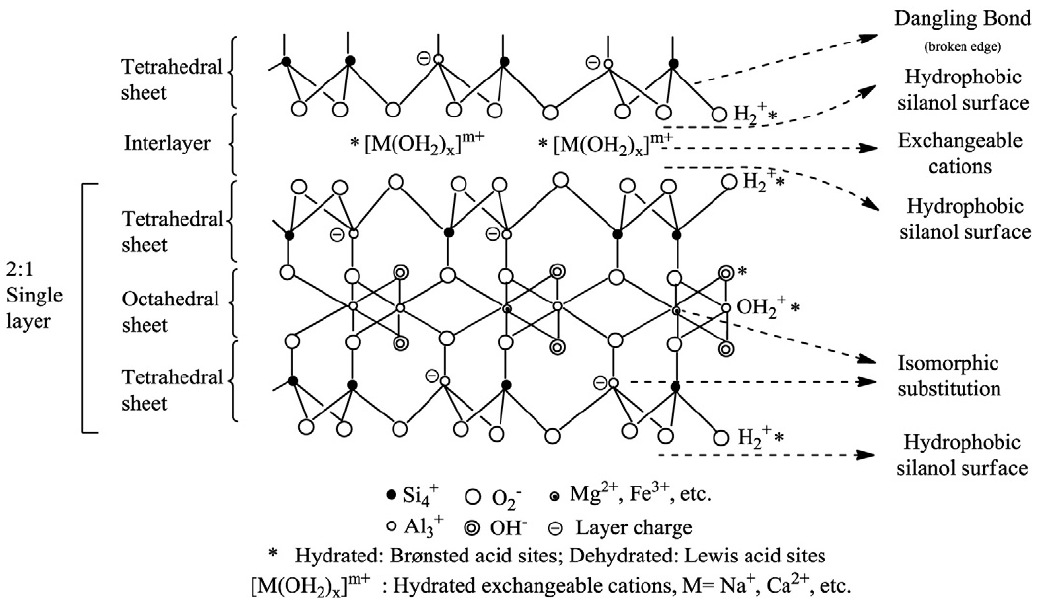
Figure 1. Clay’s general structure [118] (reprinted from Publication Appl. Clay Sci. 74, C. H. Zhou, J. Keeling, Fundamental and applied research on clay minerals: From climate and environment to nanotechnology, 3–9 (2013) with permission from Elsevier).